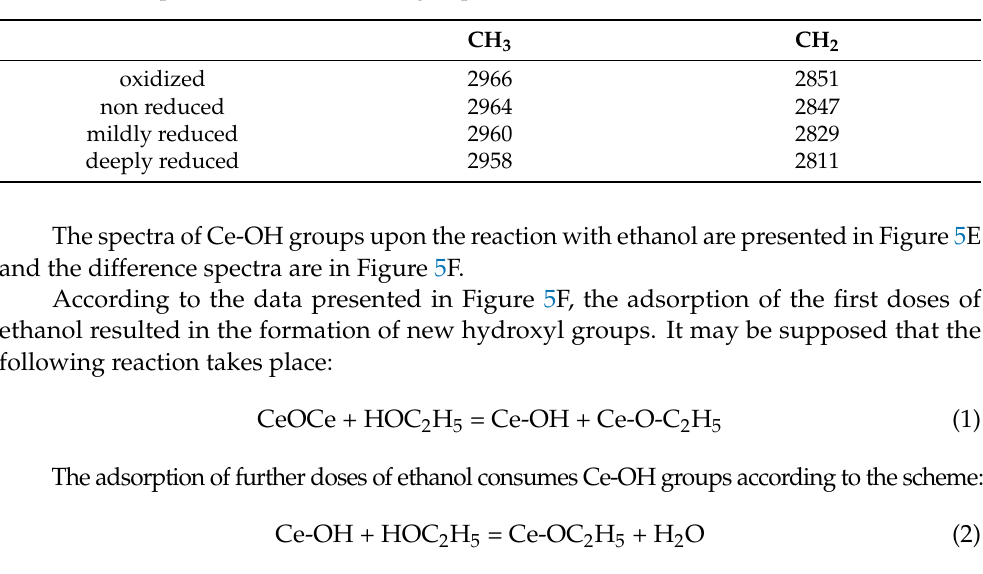
Table 3. The frequencies of CH 3 and CH 2 groups.